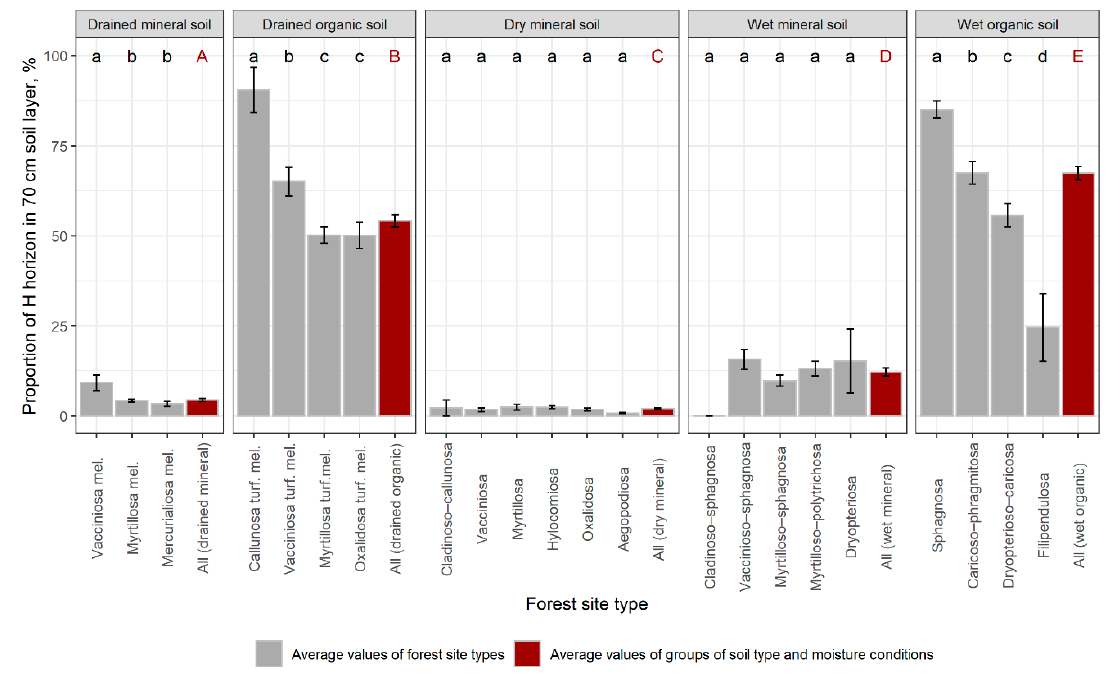
Figure 4. Proportion of the H horizon in the top 70 cm soil layer in forest land in Latvia. The division into groups based on soil types and moisture conditions is based on forest site types according to the national forest classification. Error bars represent standard errors. Different lower-case letters (black) show statistically significant differences ( p < 0.05, α = 0.05) in average values between forest site types within a group of soil type and moisture conditions; different upper-case letters (red) show statistically significant differences ( p < 0.05, α = 0.05) in average values between different groups of soil type and moisture conditions.